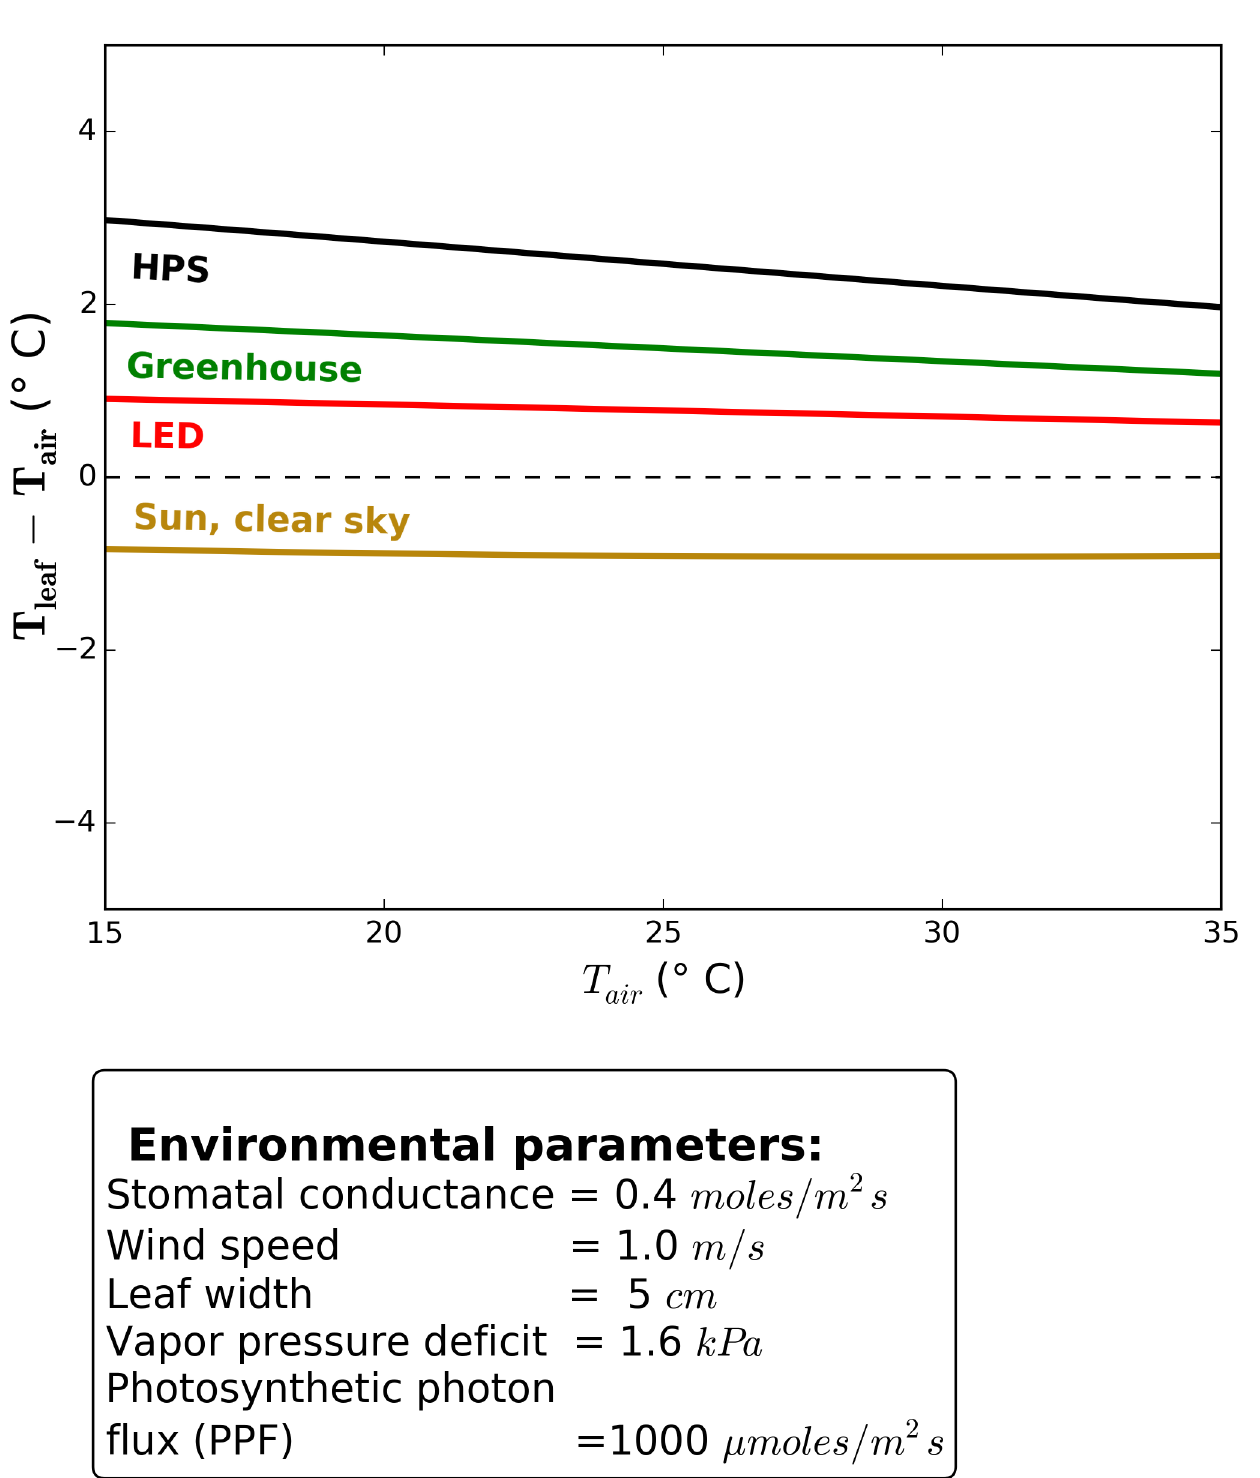
Fig 3. Leaf temperature response to air temperature. Vapor pressure deficit was held constant. Calculation is based on the average absoprtion of the four species measured. Differences among species were biologically insignificant.